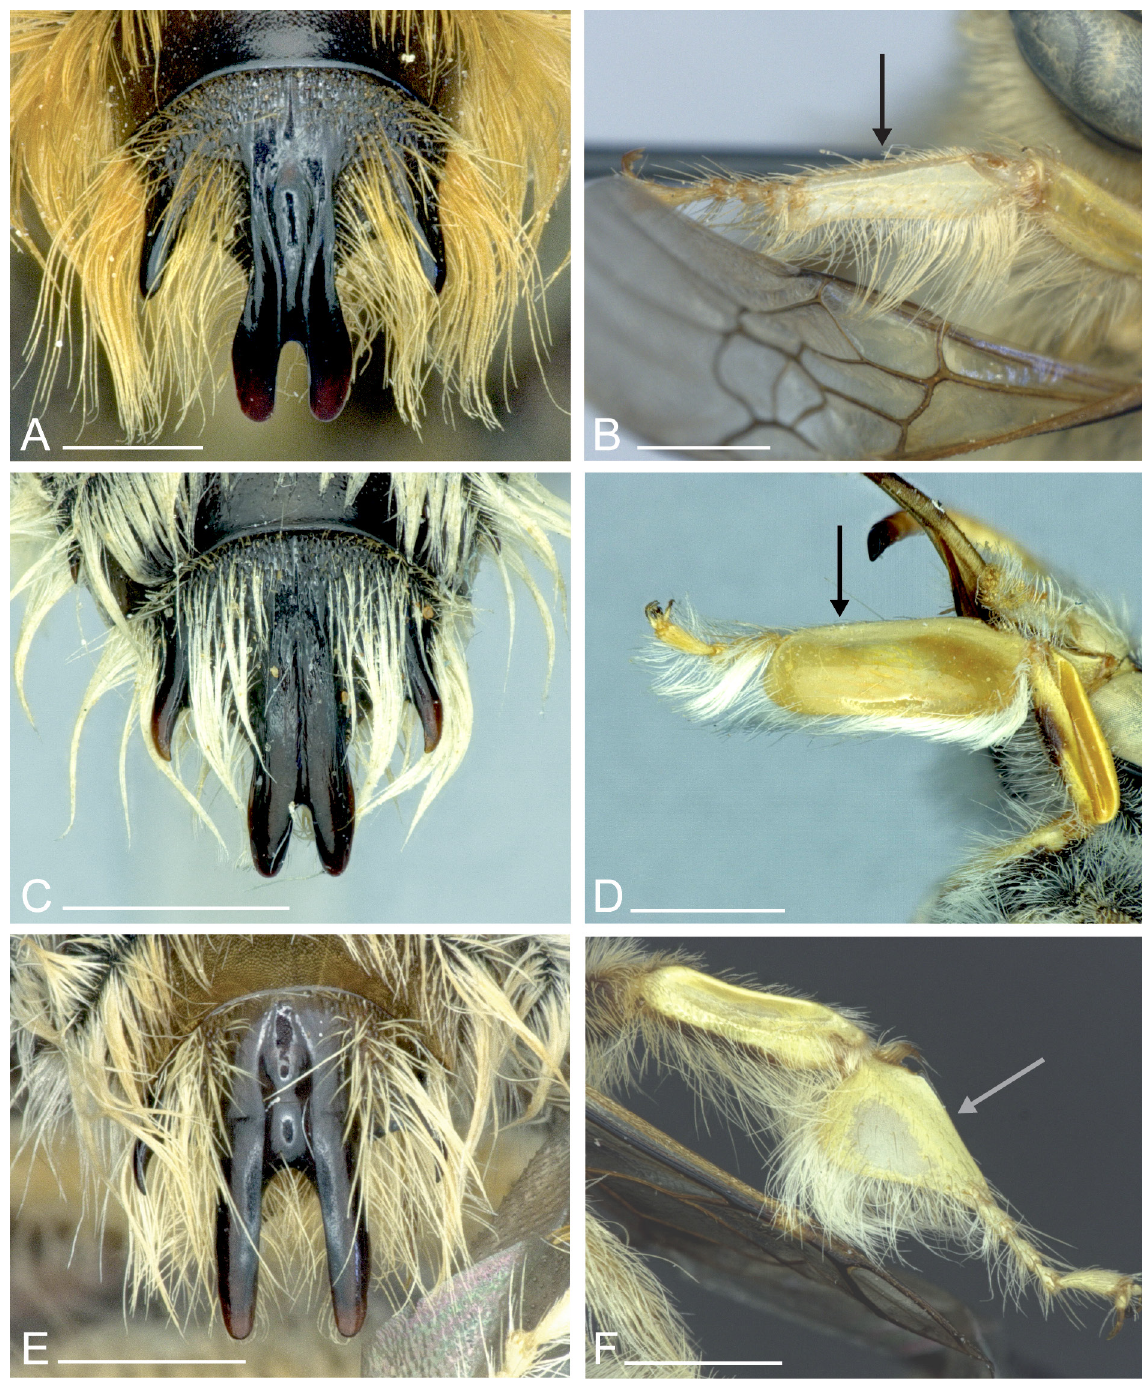
Fig. 5. Fidelia spp., ♂♂. A – B . Fidelia kobrowi Brauns, 1905. A . T7. B . Forebasitarsus. C – D . F. villosa authorship?. C . T7. D . Forebasitarsus. E–F . F. paradoxa Friese, 1899. E . T7. F . Forebasitarsus. Scale bars: 1